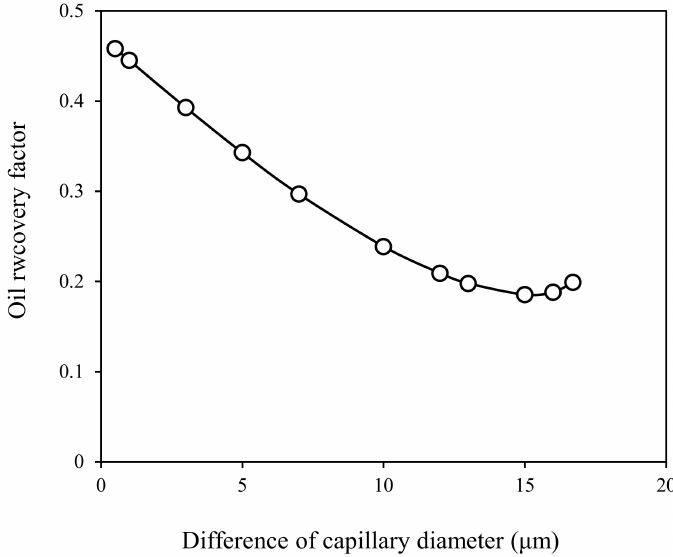
Figure 5. Relationship between imbibition recovery factor and capillary size